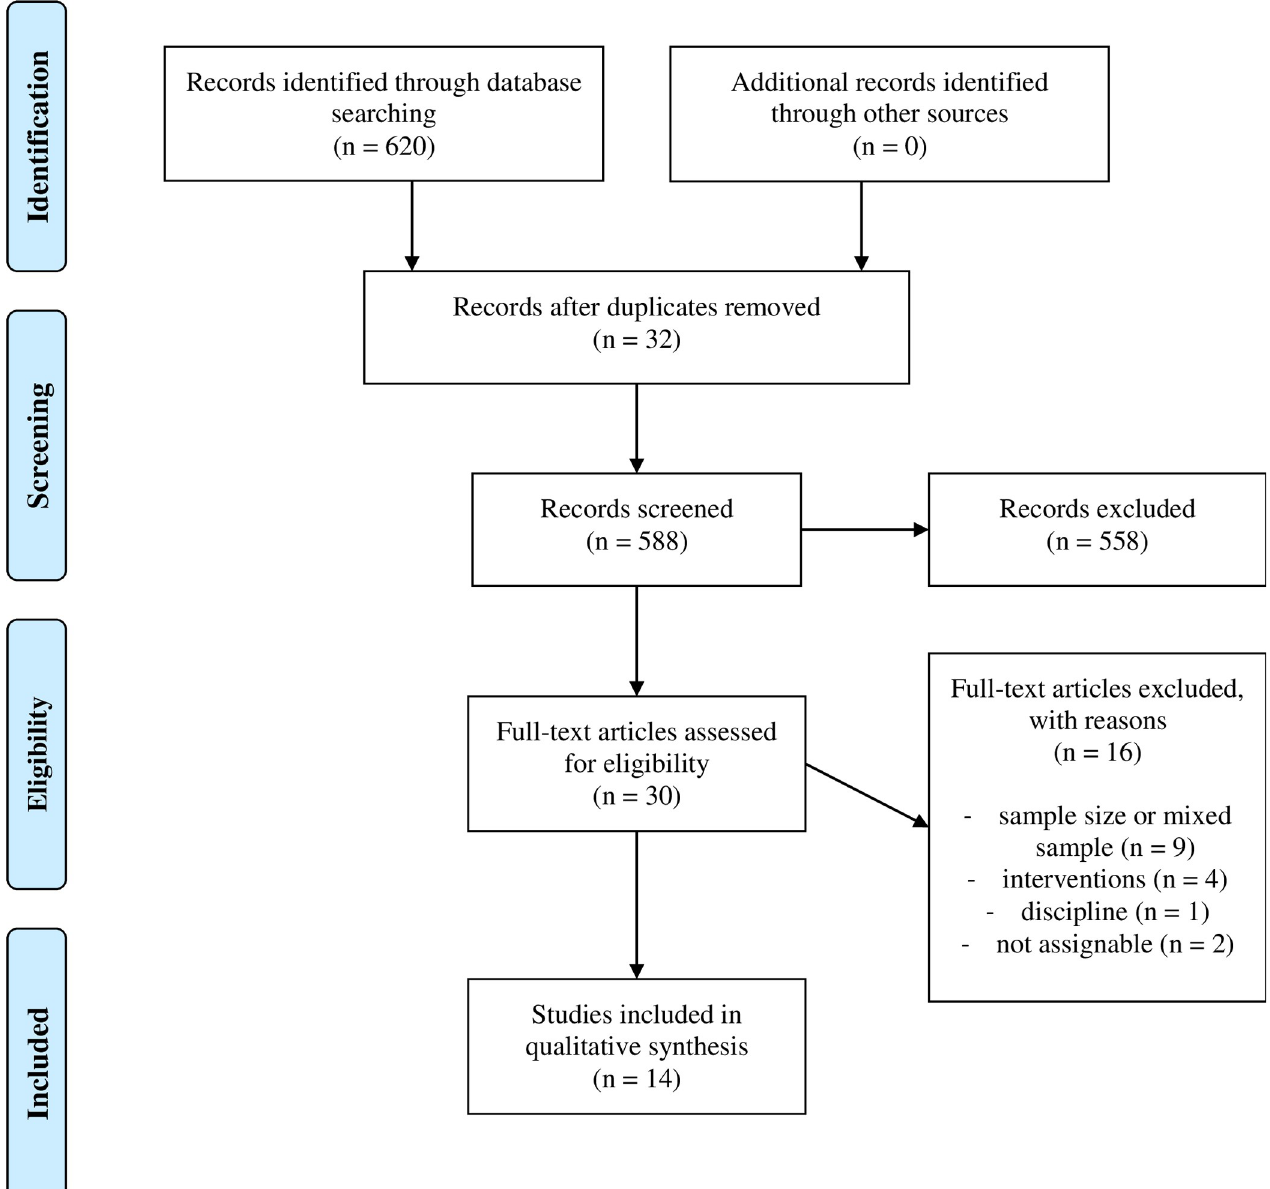
Fig 1. Flow diagram of the search strategy and the article selection